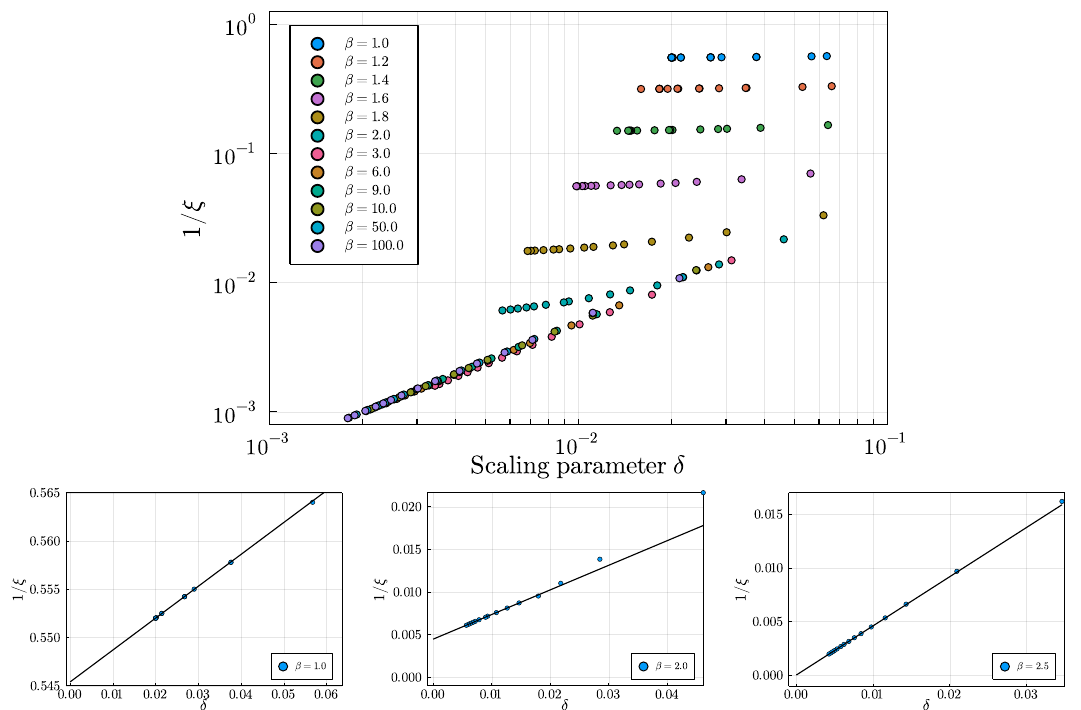
) for different E = 6. B